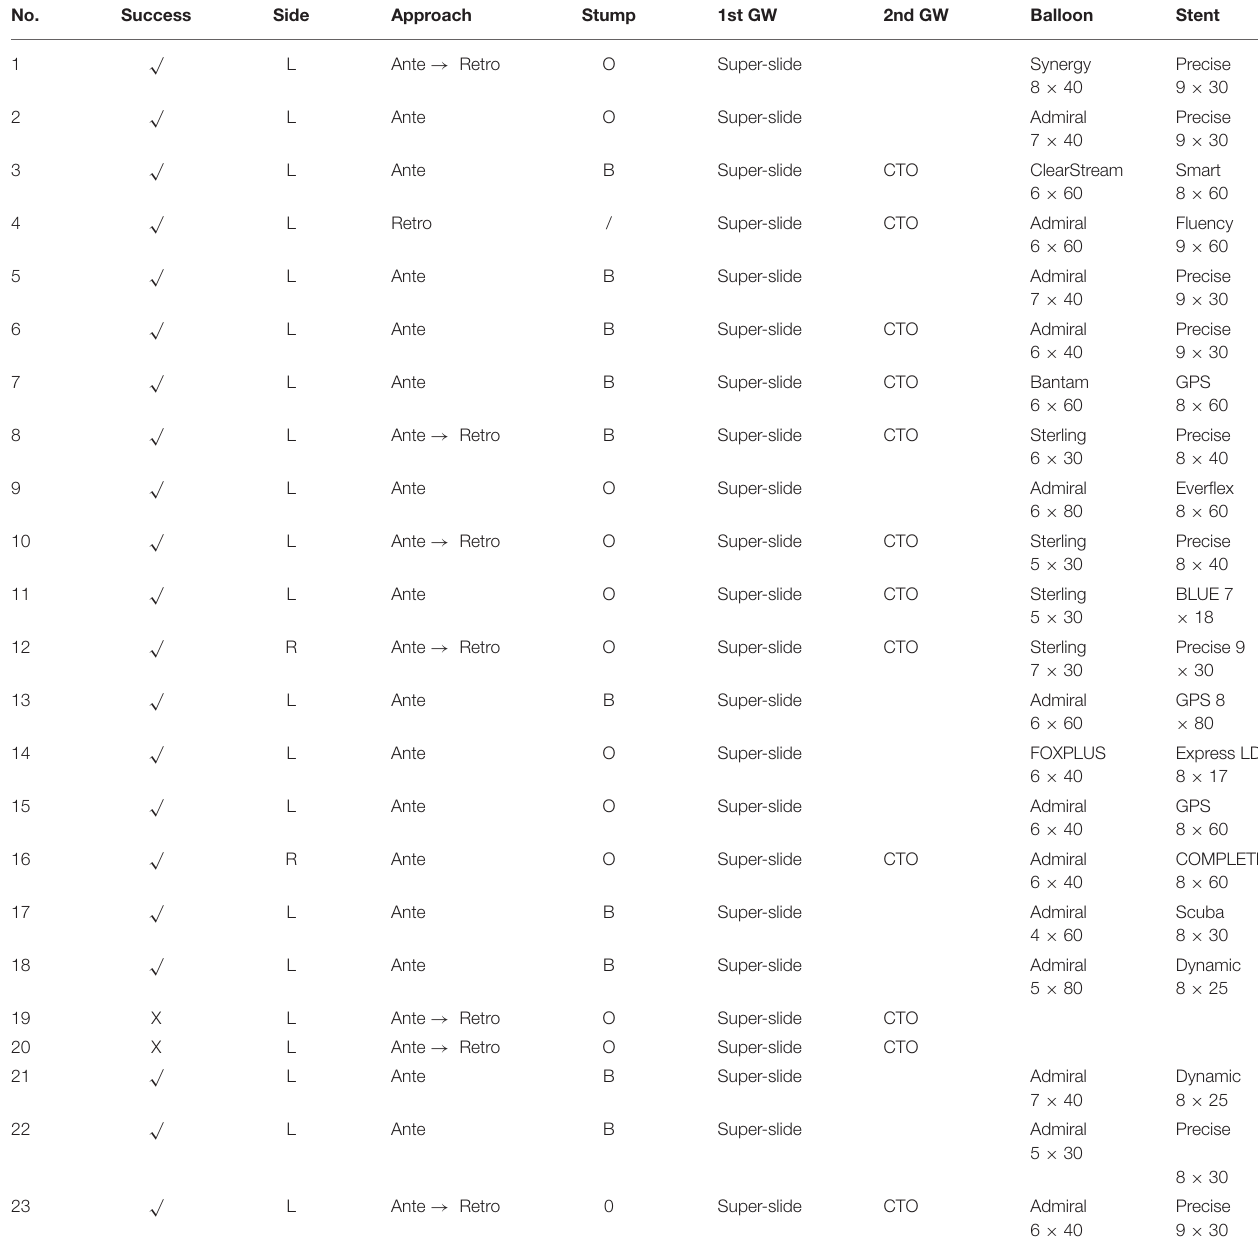
TABLE 3 | Lesion and procedural details (mm).